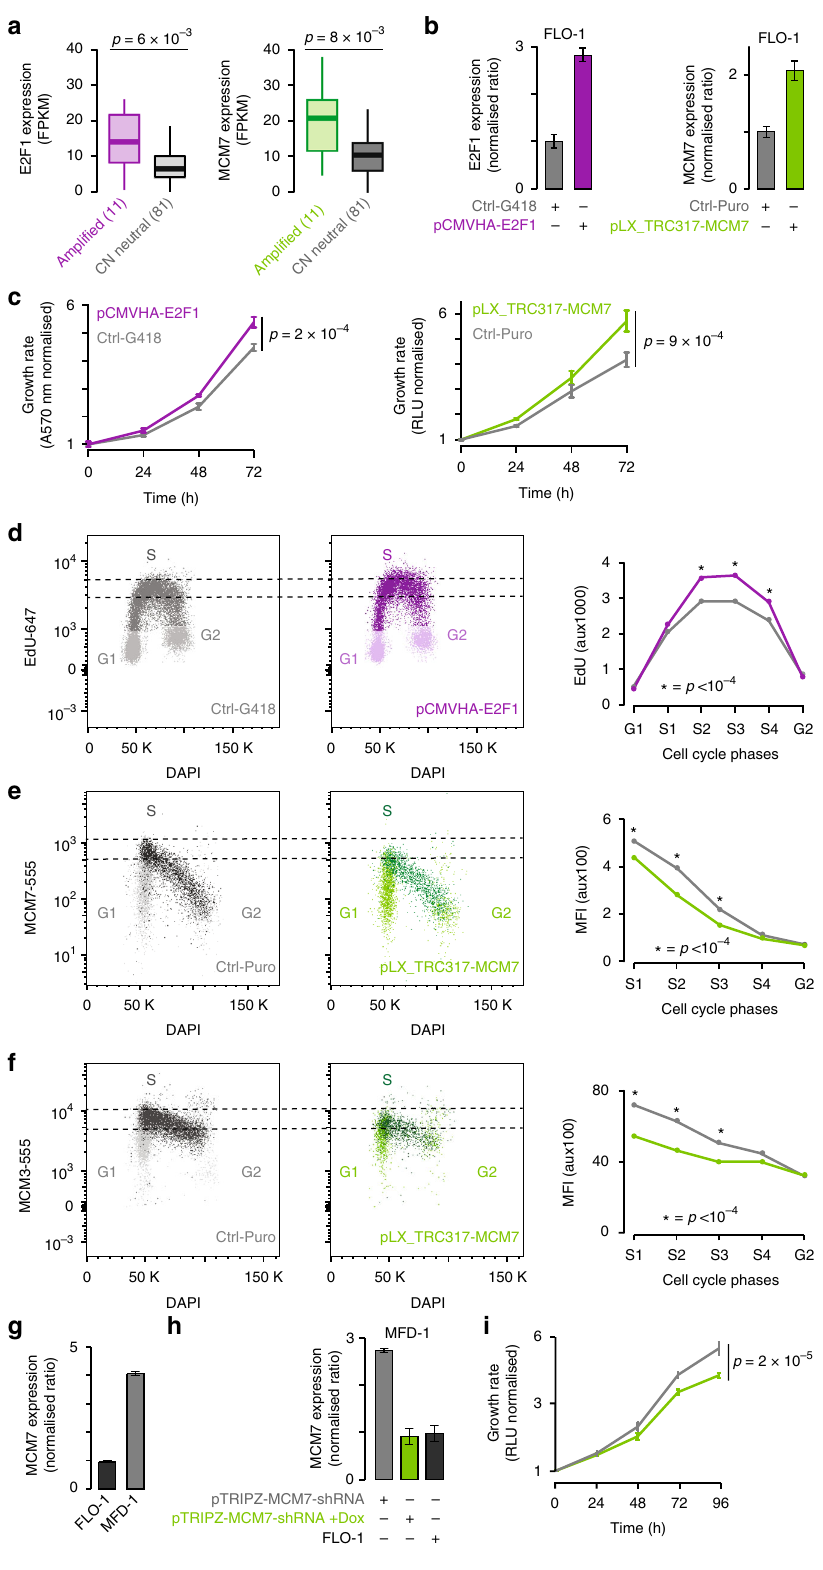
(Supplementary Table 3) to reduce MCM7 expression in MFD-1 Next, we evaluated the role of rarely altered helpers, such as cells to the level of FLO-1 cells (Fig. 4h). This led to a signi fi cant NCOR2 that is altered in eight EACs across fi ve of the six clusters decrease in proliferation ( p = 2 × 10 – 5 , two-tailed t -test; Fig. 4i), (Supplementary Data 3). NCOR2 contributes to the nuclear indicating that MFD-1 cells rely on MCM7 overexpression for receptor corepressor complex that favours global chromatin their growth. deacetylation and transcriptional repression 5,30 (Fig. 5a). NATURE COMMUNICATIONS| (2019) 10:3101